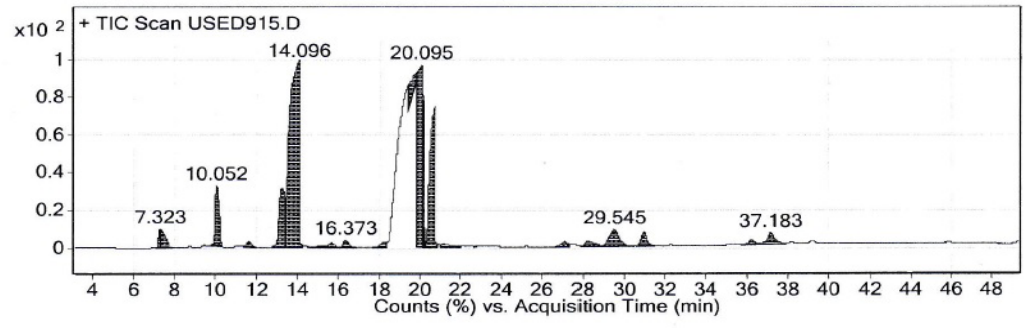
Figure 8: The chromatograms of used cooking oil after transesterification using calcined CaO.